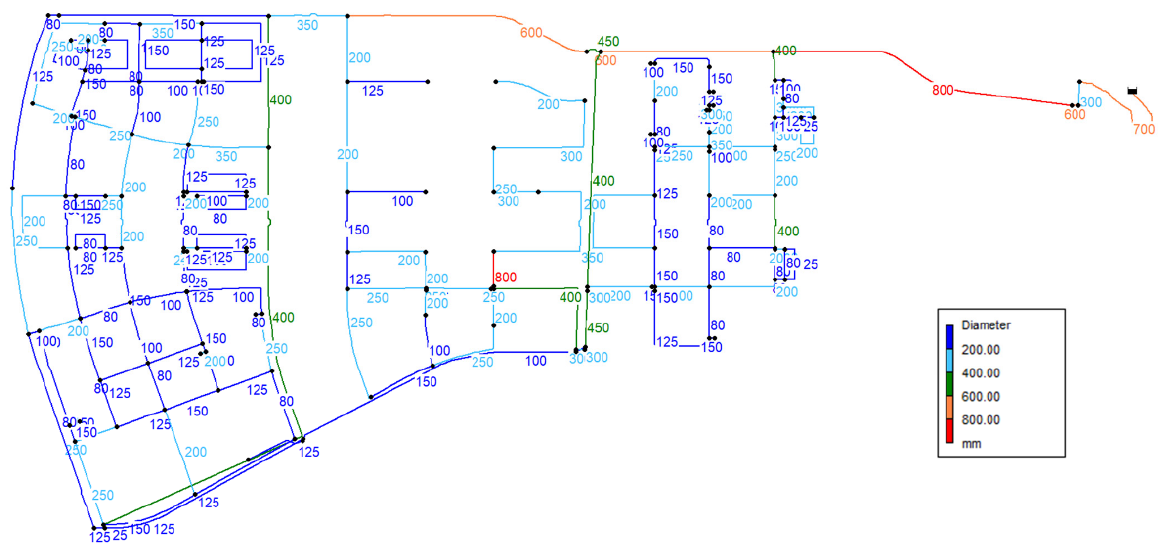
Figure 4. EPANET model of the Cheongna WDN, highlighting the optimal pipe diameters calculated using the HS